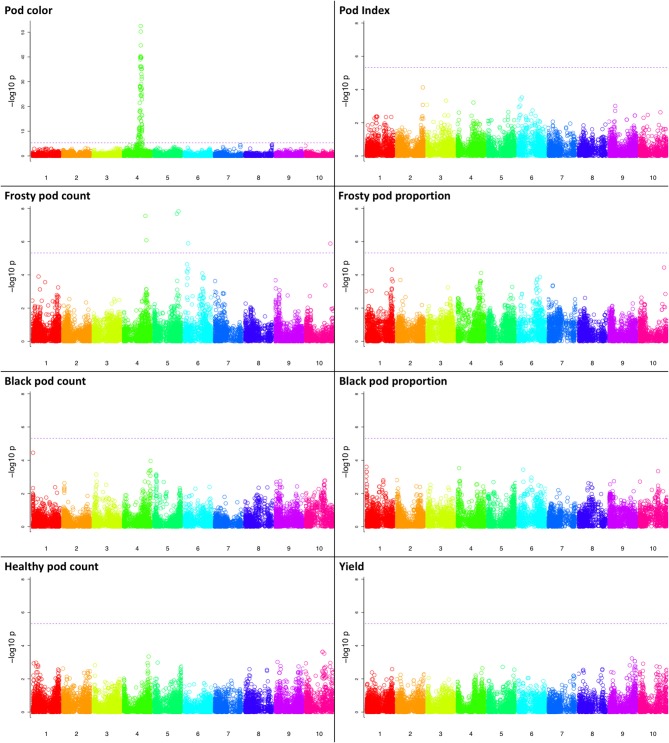
Manhattan plots of the genome wide association results for all traits. Along the x-axis are the genome positions (using the Matina genome assembly as reference) for the cacao chromosomes, with the chromosomes being color-coded. The y-axis corresponds to the p-value from the association model. The horizontal dotted line corresponds to the Bonferroni threshold for statistical significance.